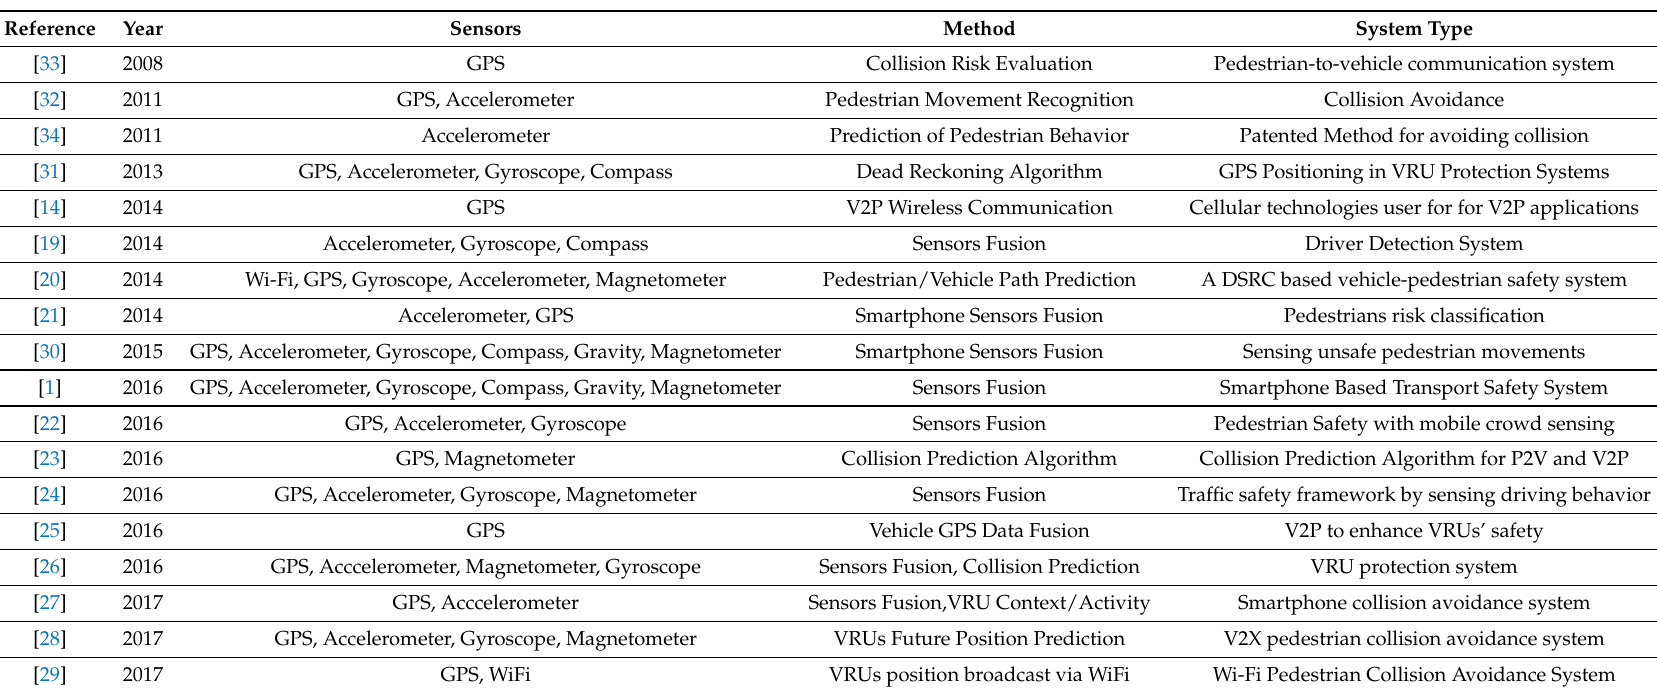
Table 2. P2V/V2P literature review